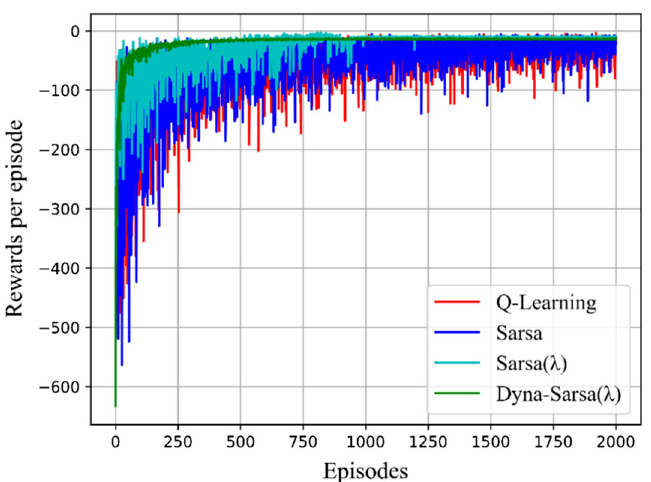
Fig. 9 Comparison of ship reward value for each iteration. The performance comparison of ship reward value achieved by the proposed model and baselines for each iteration